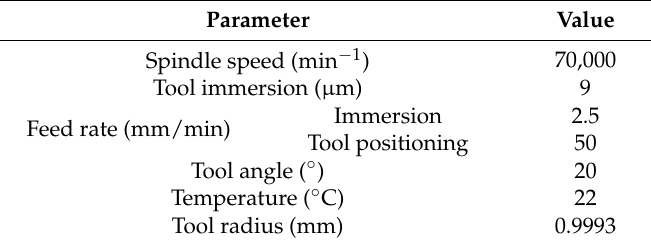
Table 1. Machining parameters for the fabrication of the MLA mold insert by means of UP-milling.